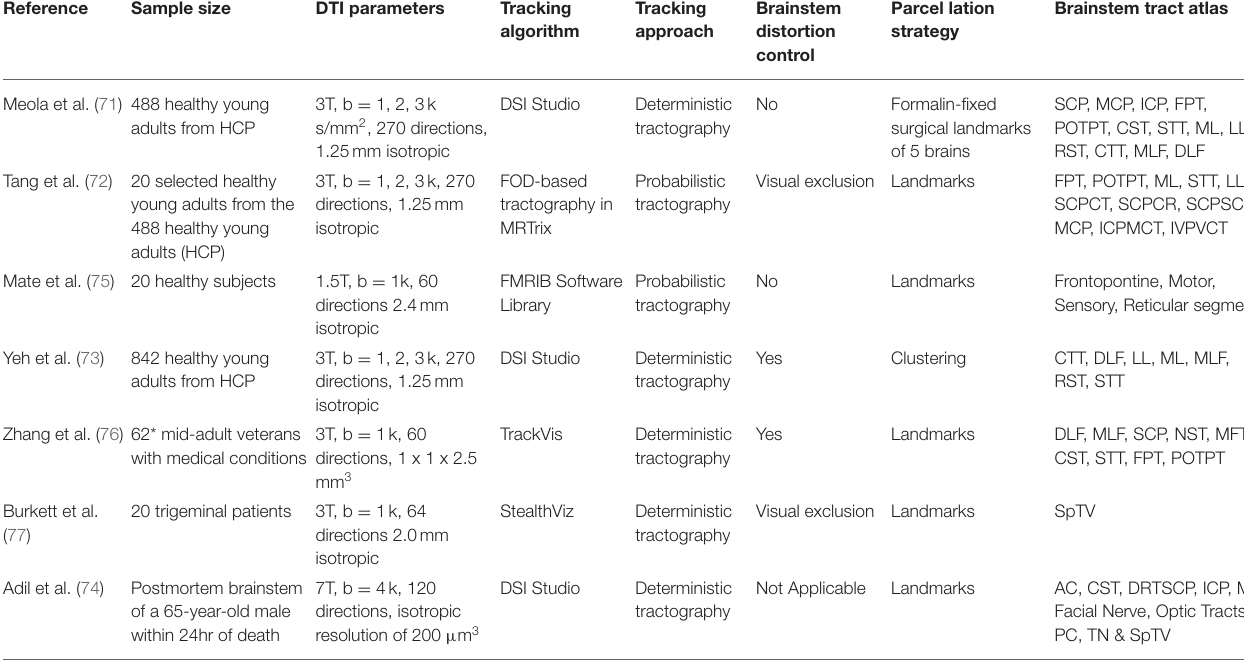
TABLE 2 | Summary of studies of brainstem atlas